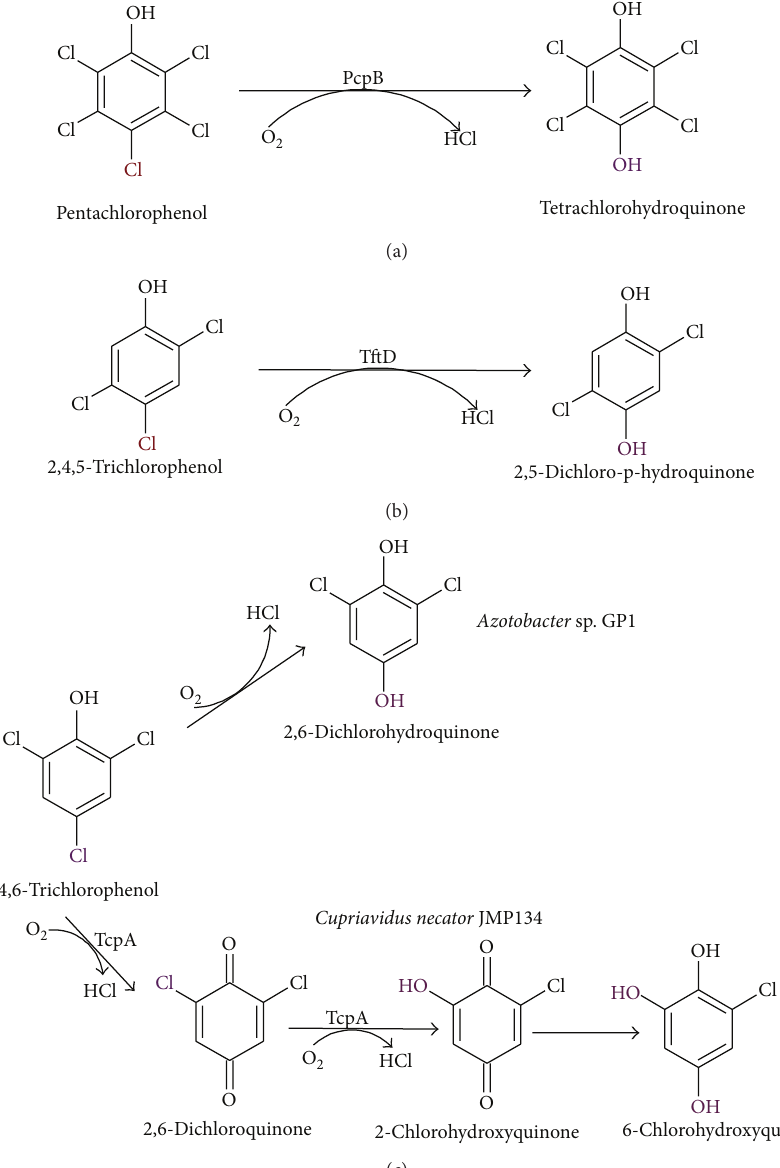
Figure 3: Monooxygenase type dehalogenation of (a) pentachlorophenol by pentachlorophenol-4-monooxygenase (PcpB); (b) 2,4,5- trichlorophenol by chlorophenol monooxygenase (TftD) and (c) 2,4,6-trichlorophenol by 2,4,6-trichlorophenol monooxygenase.